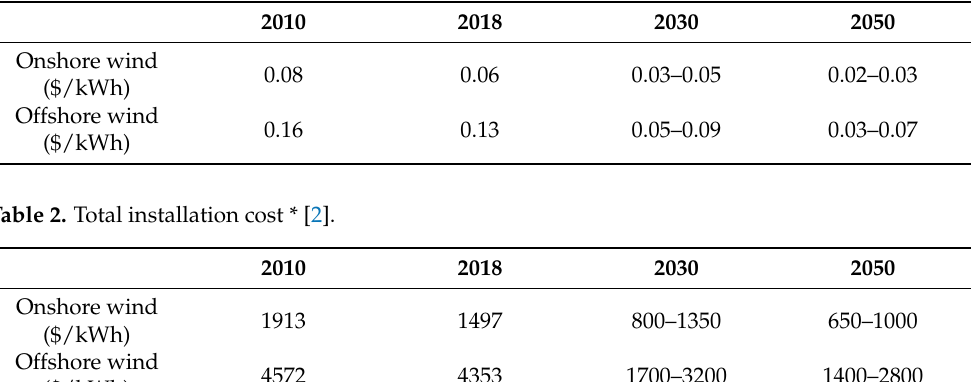
Table 1. Levelized cost of electricity from wind energy [2].